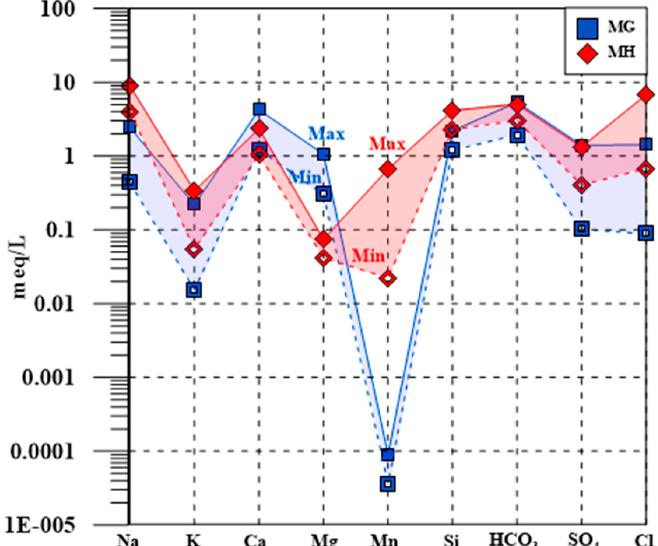
Figure 4. Schöeller diagram comparing concentration ranges of major ions in thermal water (MH) and groundwater (MG). Filled and open symbols indicate maximum and minimum values, respectively.